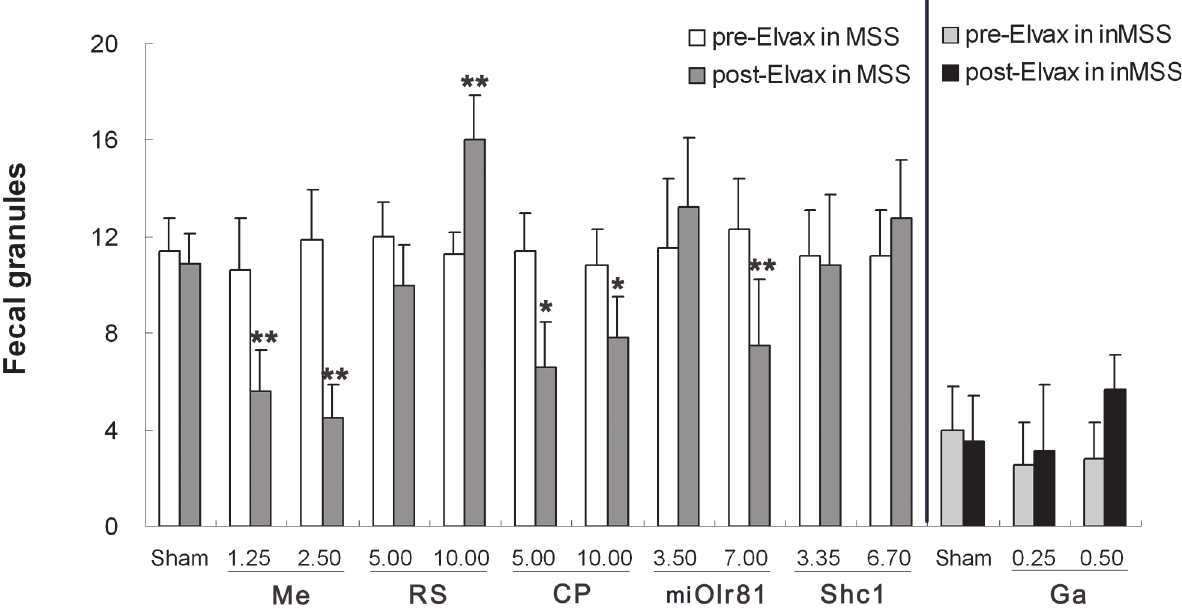
Fig 5. Effects of Elvax implantation over the CVN on the defecation response induced by rotation stimulation. In MSS animals, Elvax was loaded with solvent (Sham); 1.25 or 2.50 mM mecamylamine (Me); 5.00 or 10.00 mM RS39604 (RS); 5.00 or 10.00 mM CP99994 (CP); 3.50×10 7 or 7.00 ×10 7 GFU/ml pAd-shOlr81 (shOlr81); or 3.35 ×10 8 or 6.70 ×10 8 GFU/ml pAd-Shc1 (Shc1) at final concentration/titer (n = 5 in each group). In inMSS animals, Elvax was loaded with solvent (Sham) or gabazine (Ga) to a final concentration of 0.25 or 0.5 mM (n = 5 in each group). All data presented are expressed as the means and the vertical bars represent SEM. Statistical significance: ** P < 0.01, * P < 0.05 compared with the rotation-induced defecation response before Elvax implantation.